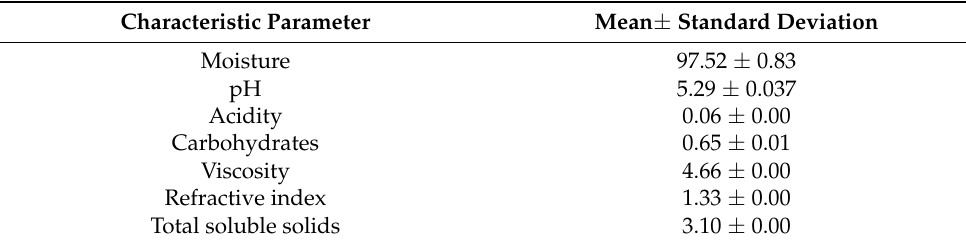
Table 1. Physicochemical characteristics of